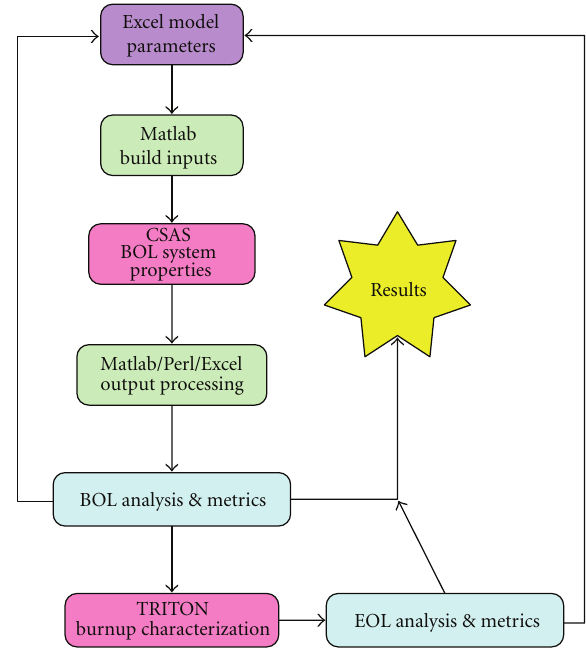
Figure 1: Applied computer code